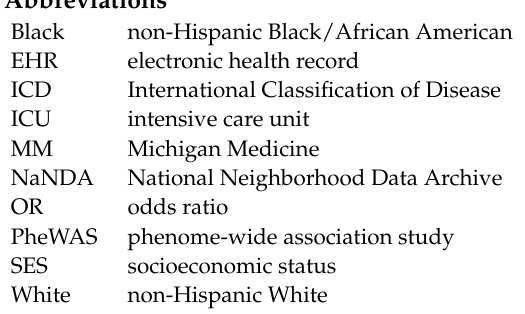
hospitalization, Figure S5: Forest plot showing nominally significant effect differences comparing Whites and Blacks with respect to COVID-19-related ICU admission, Figure S6: Forest plot showing nominally significant effect differences comparing Whites and Blacks with respect to COVID-19-related death, Figure S7: Manhattan plot showing the phenome-wide association between disease codes and testing positive for COVID-19. Models are adjusted for age, sex, race (full cohort only), and four census tract- level socioeconomic indicators: proportion with less than high school education, proportion unemployed, proportion with annual income below the federal poverty level, and population density (persons per mile 2 ). The x-axis are individual disease codes, color-coded by their corresponding disease category as described in the legend. The y-axis represents the -log 10 transformed p-value of the association. The dashed, horizontal lines represent the p = 0.05 (in orange) and the Bonferroni corrected p -value (0.05/number of tests; in red). Each point is represented by either an upward triangle indicating a positive association or a downward triangle indicating a negative association, Table S1A: Definition and Sources of All Variables, Table S1B: Analysis Setup, Table S2: Descriptive cohort characteristics stratified by race, Table S3: “COVID-19 Positive vs. Controls” PheWAS Merged Top 50 Traits Using Adjustment 2, Table S4: “Hospitalized vs. Alive & Not hospitalized” PheWAS Merged Top 50 Traits Using Adjustment 2, Table S5: “ICU & Dead vs. Alive & no ICU Stay” Merged PheWAS Top 50 Traits Using Adjustment 2, Table S6: “Deceased vs. Alive” Merged PheWAS Top 50 Traits Using Adjustment